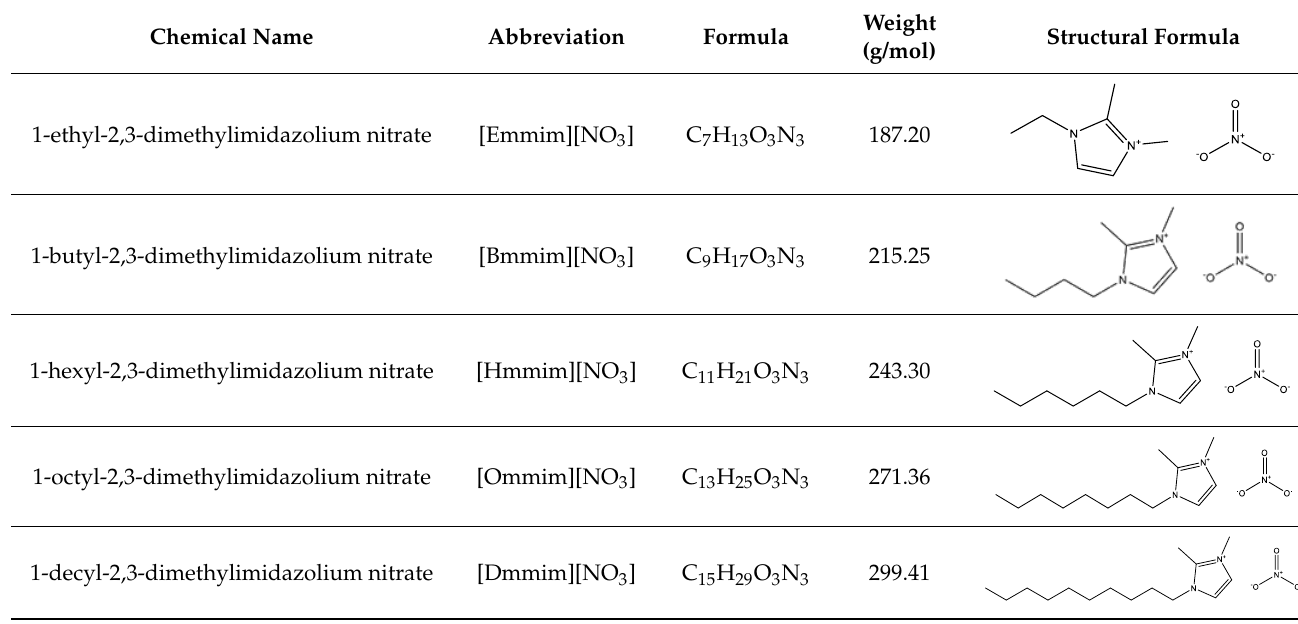
Table 1. Chemical information for five ionic liquids.